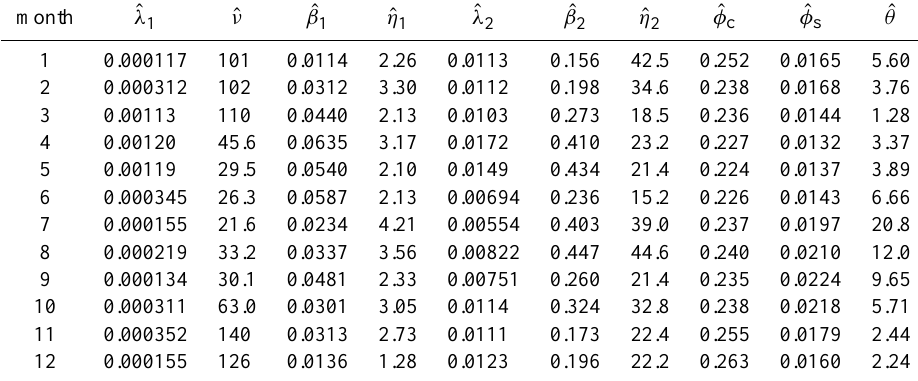
Table 2. Parameter estimates for the central region.